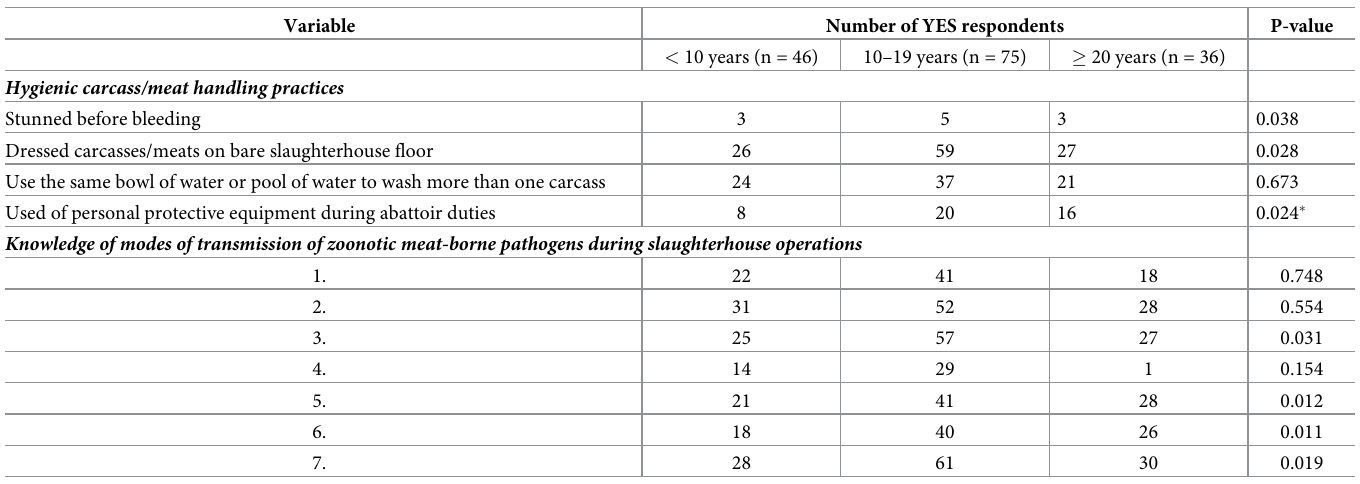
Table 4. Association between working experience of slaughterhouse workers (n = 157) and their hygienic meat processing practices and knowledge on modes of transmission of meat-borne zoonotic pathogen during routine slaughterhouse operations in Southeast Nigeria.